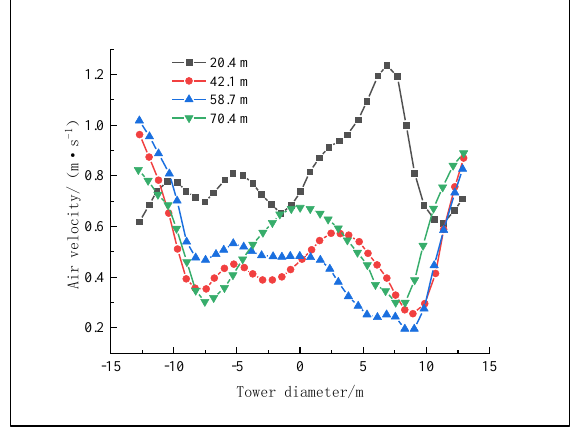
Figure 10. Radial distribution of air velocity in the cross section of the granulation tower.